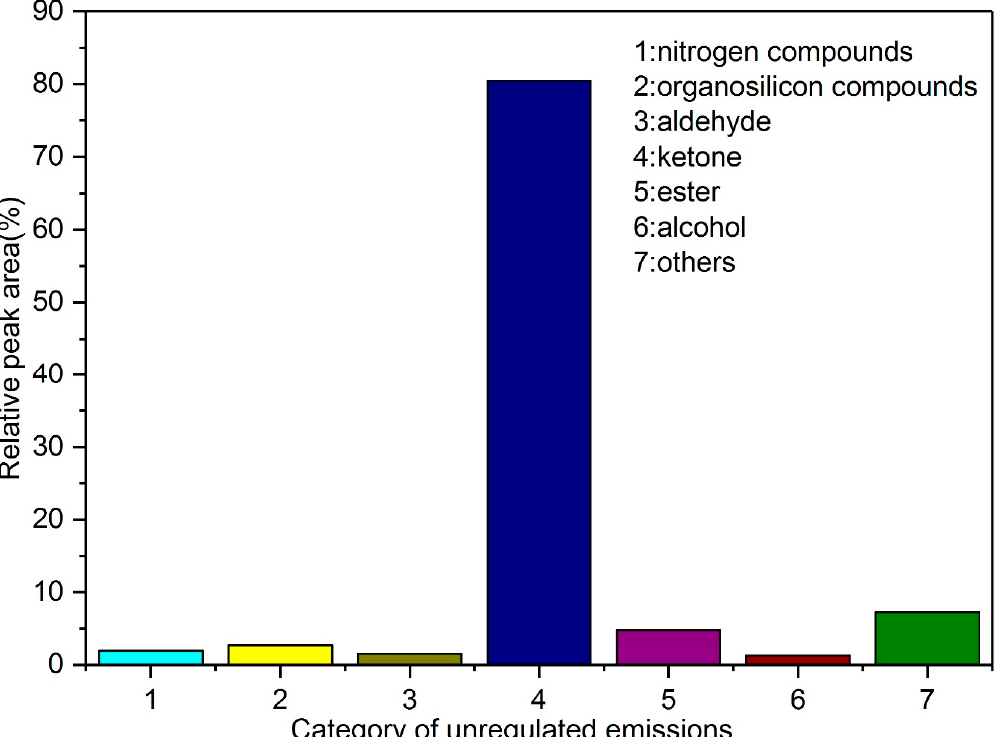
Figure 9. Relative concentration of unregulated emissions absorbed by activated carbon in PPCI. J. Mar. Sci. Eng. 2020 , 8 , 101